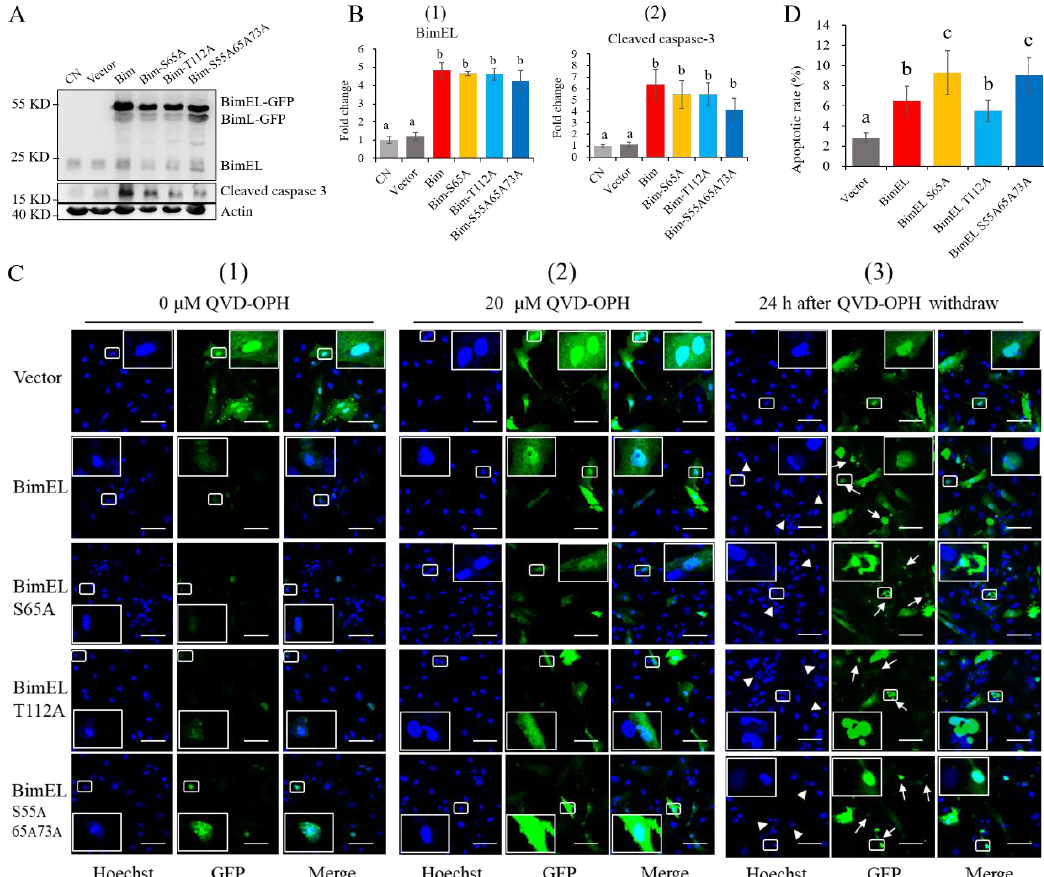
Figure 4. E ff ects of BimEL phosphorylation sites mutation on apoptosis of porcine granulosa cells. Porcine granulosa cells were transfected with vector (pEGFP-N1), BimEL (pEGFP-N1-BimEL), BimEL-S65A (pEGFP-N1-BimEL-S65A), BimEL-T112A (pEGFP-N1-BimEL-T112A), and BimEL-S55 A 65 A 73 A (pEGFP-N1-BimEL-S55 A 65 A 73 A ) plasmids, and the CN was the transfection control. Values are expressed as means ± SD from five independent experiments. The bars labeled with completely di ff erent letters indicate significant di ff erence, p < 0.05. ( A ) The levels of recombinant Bim-GFP proteins were compared among the porcine granulosa cells transfected with di ff erent plasmids. The cells were harvested for Western blot after transfection for 24 h. ( B ) The results of quantitative analysis of BimEL (B-1) and cleaved caspase-3 (B-2) levels in di ff erent groups. ( C ) The treatment of QVD-OPH increased the numbers of green positive cells after transfection with BimEL and BimEL phosphorylation site mutations. The cells from each plasmid transfection were equally divided into three groups and were cultured in one slide. (C-1) The cells in the 0 µ M QVD-OPH (DMSO control). (C-2) The cells of 20 µ M QVD-OPH groups were cultured for 24 h. The Cells (C-3) were cultured in the medium containing 20 µ M QVD-OPH for 24 h and then cultured in the same medium without QVD-OPH for another 24 h. After culturing, the cells were fixed with 4% paraformaldehyde and stained with Hoechst 33342. The samples were analyzed with a laser confocal scanning microscope. Representative images are shown. Scale bar = 100 µ m. Triangle indicates the fragmented or shrunk nuclei. Arrows point out the shrinkage cells. ( D ) Apoptotic rates of green positive cells after transfection with BimEL and BimEL with di ff erent phosphorylation site mutations. QVD-OPH (20 µ M) was administrated immediately after transfection. After 24 h, QVD-OPH was taken out, and the cells were harvested after an additional 24 h for Annexin V and 7-AAD staining, followed by flow cytometry analysis. The green positive cells were further analyzed for Annexin V and 7-AAD. The percentages of apoptotic cells (Annexin V positive) from each group were